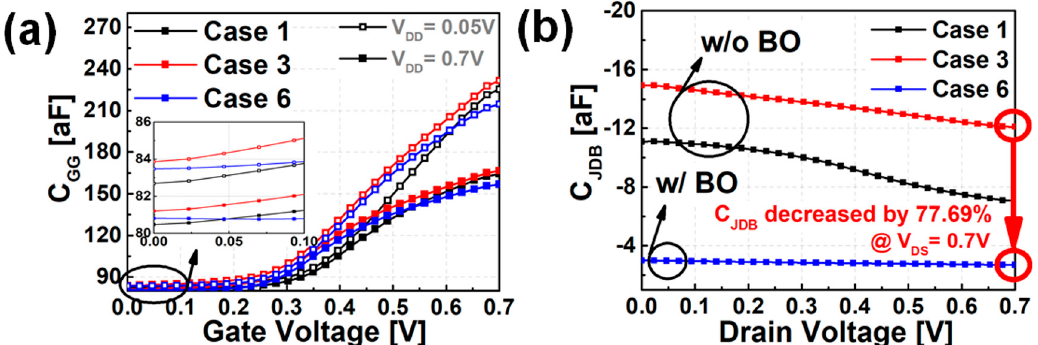
Figure 4. ( a ) PTS doping concentration versus C GG for case 1, 3, 6, ( b ) C JDB versus drain voltage for case 1, 3,